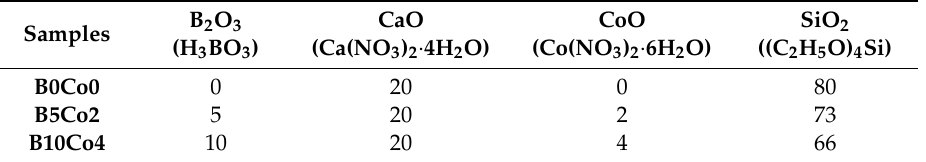
Table 1. Designed compositions of BCo.BGNs in mol% and reagents used.